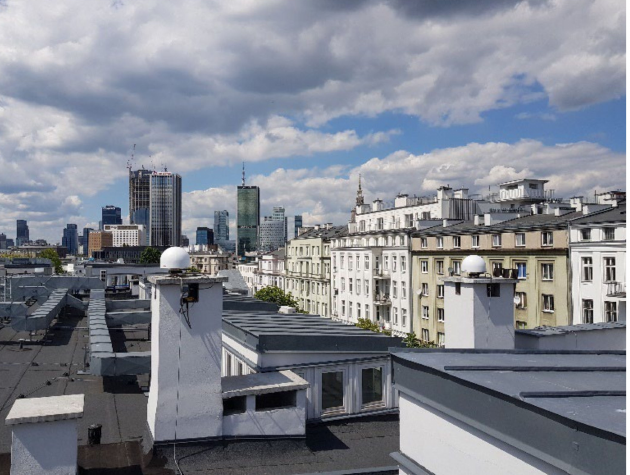
Figure 1. GNSS reference stations on the roof of the Main Building of the Warsaw University of Technology—WUT1 station on the right side.